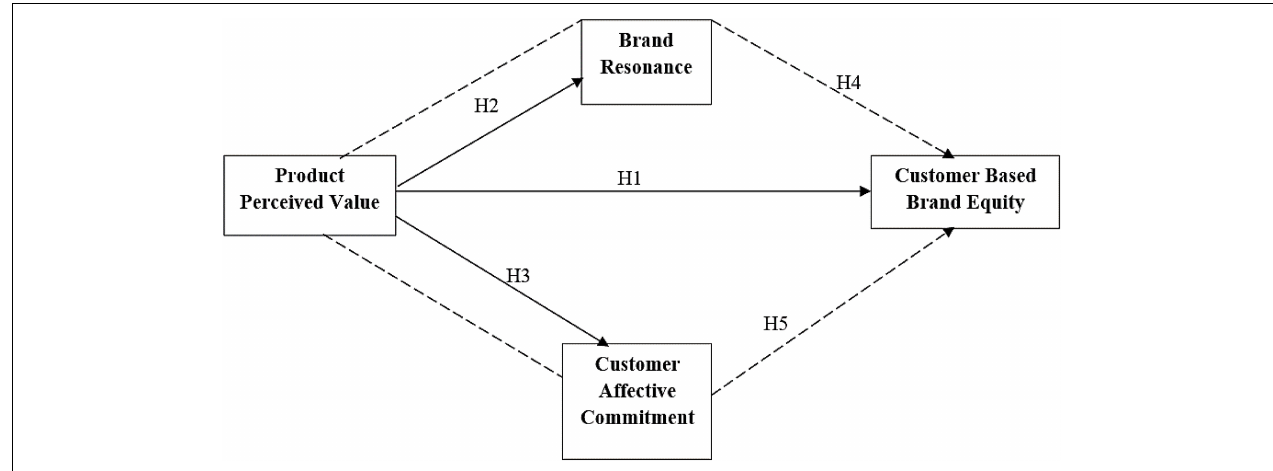
FIGURE 1 | Theoretical